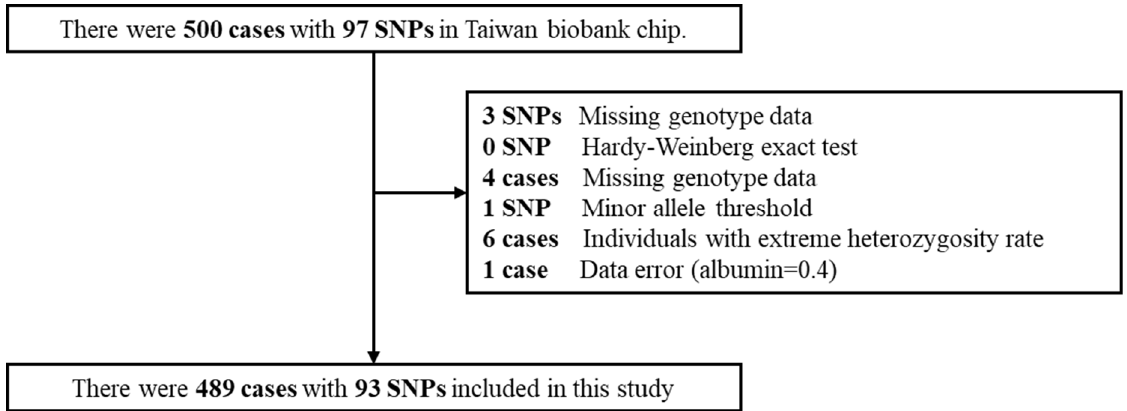
Figure 1. The selections of participants and SNPs in Taiwan Biobank.